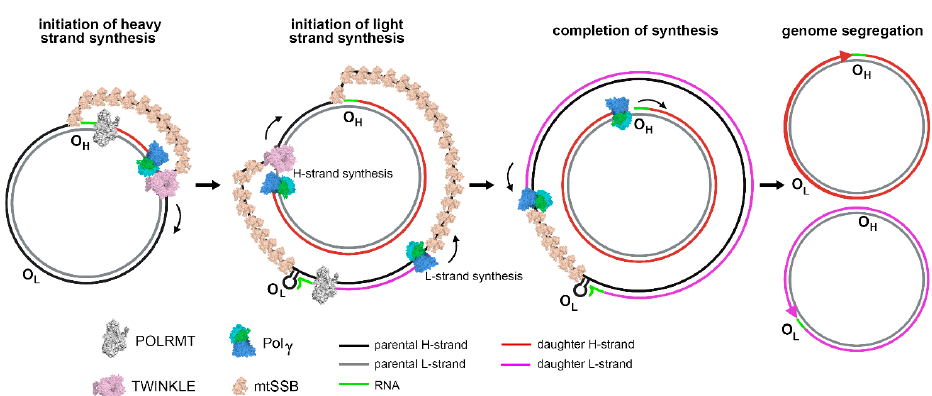
Figure 1. Human mtDNA genes, adopted from [11,12].